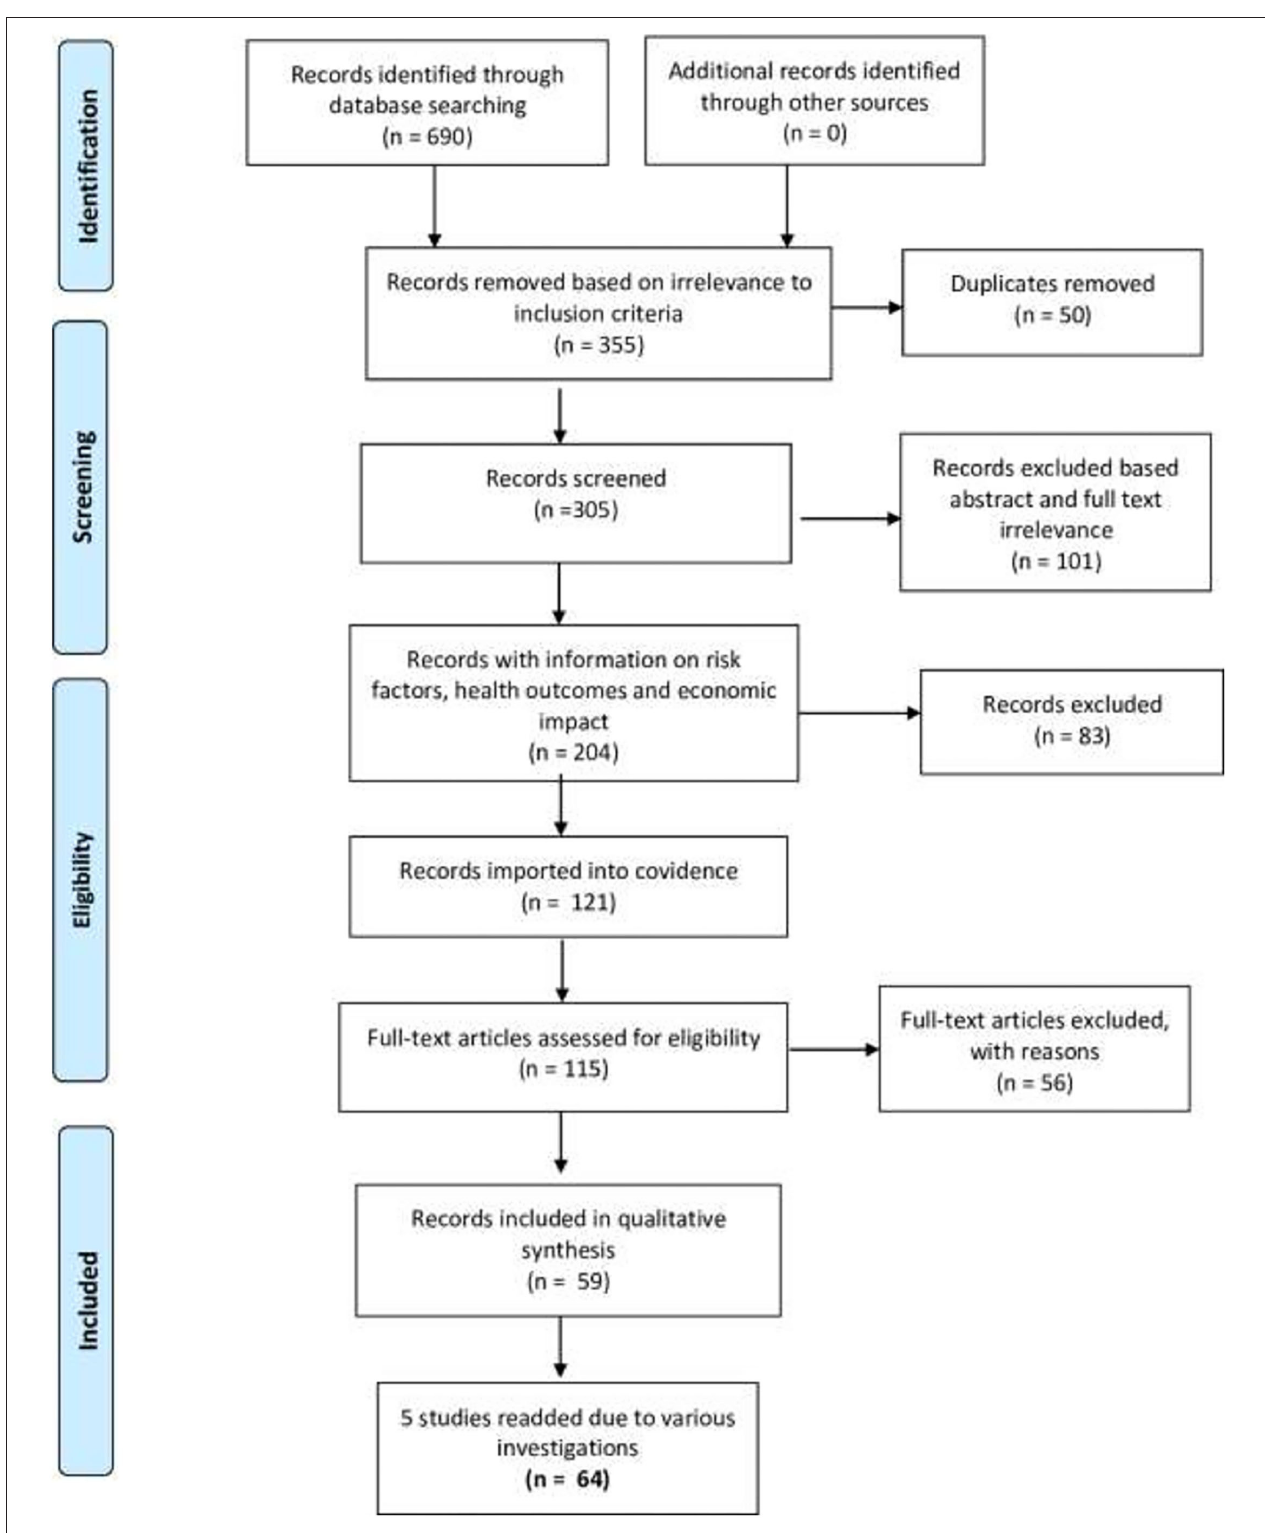
FIGURE 1 | Flow diagram indicating the process of study retrieval and inclusion as described in the PRISMA statement.